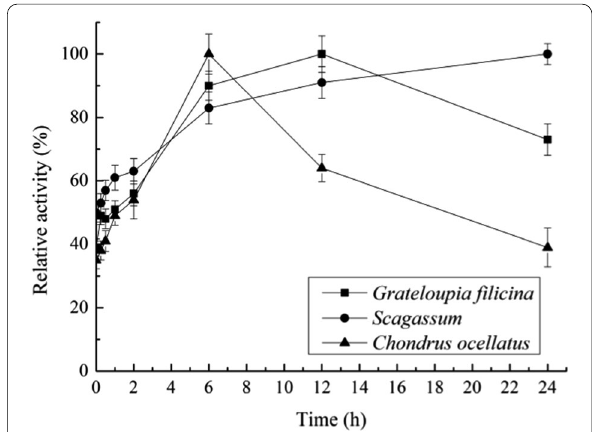
Fig. 6 Relative activity of Amy2587 during degradation of three seaweed substrates, Grateloupia filicina , Chondrus ocellatus , and Scagassum